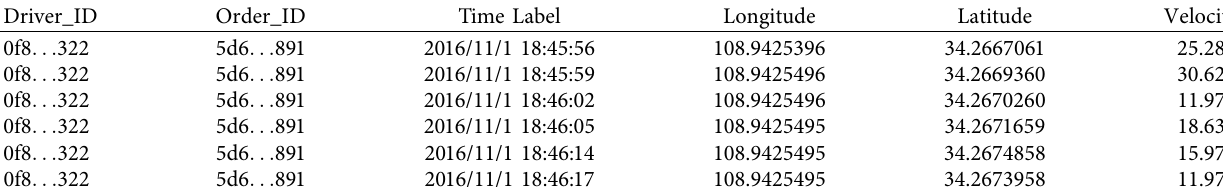
Table 1: Examples of initial experimental datasets.